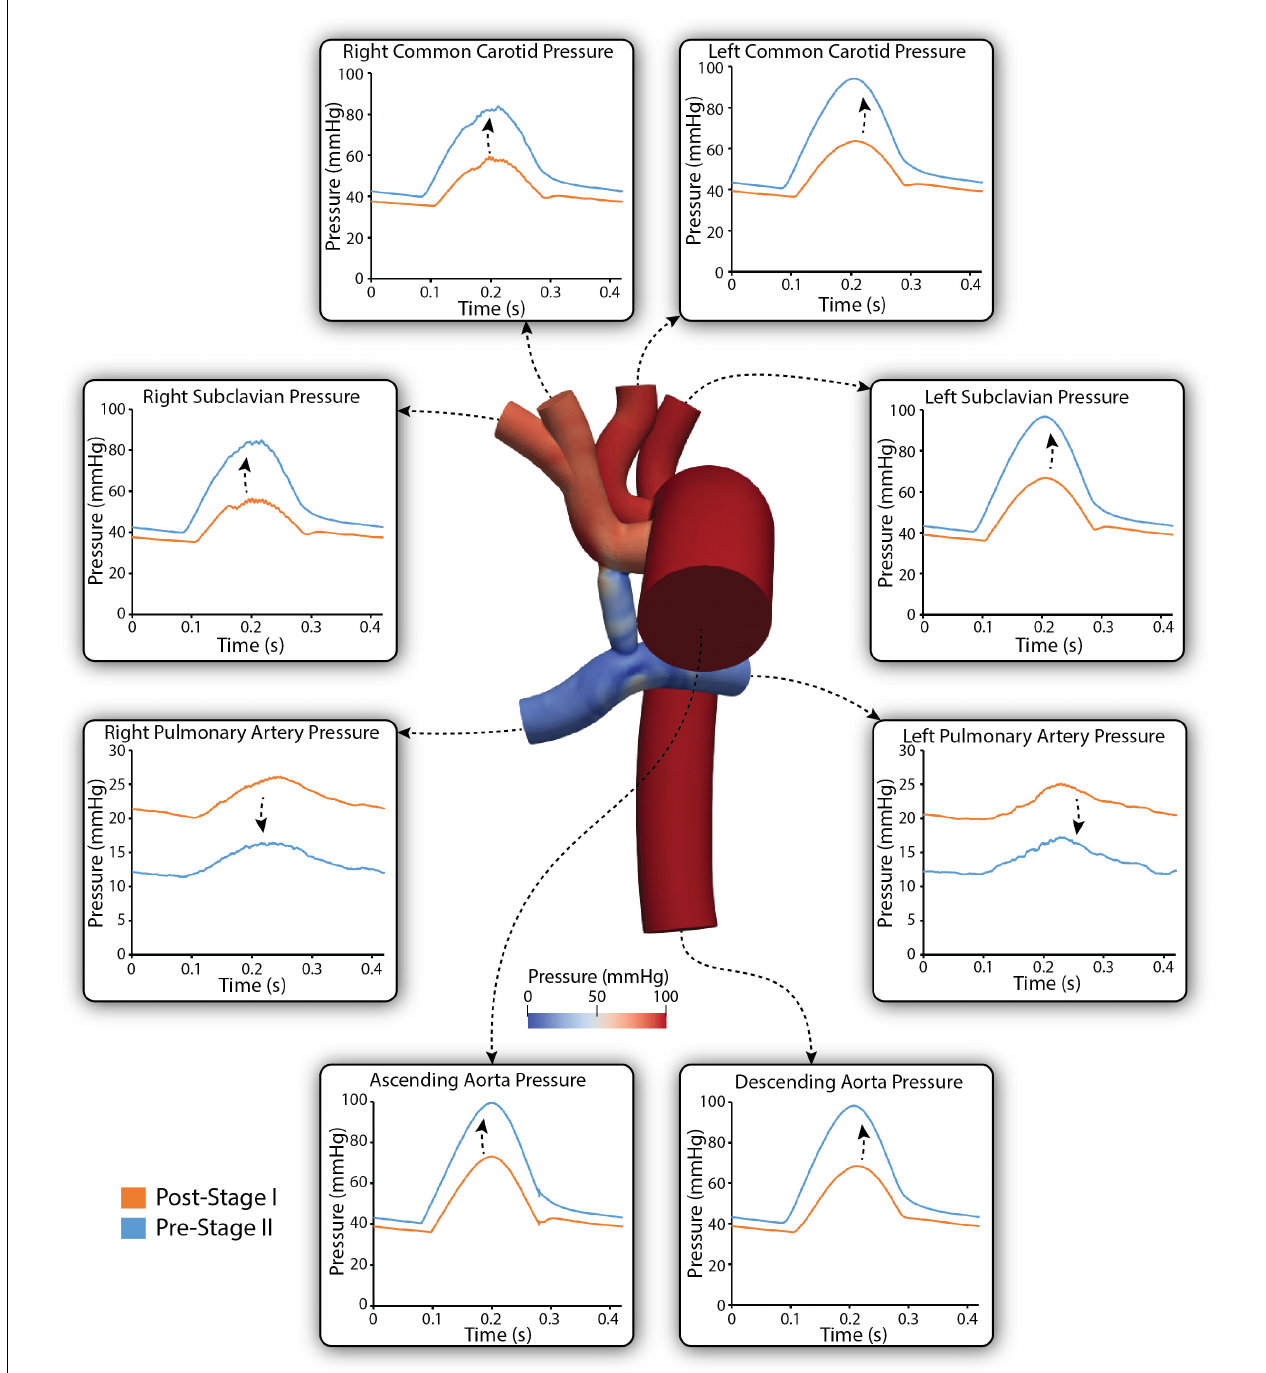
FIGURE 7 | Simulated pulsatile pressures at all boundaries of the 3D domain for both post-S1 (orange) and pre-S2 (blue) models. Arrows indicate whether pressure increased or decreased from post-S1 to pre-S2. Note that two different y -axis scales have been used: one for the LPA and RPA, and a second for the remainder of the outlets. A pressure coloring on the surface of the pre-S2 model is shown during peak-systole ( t = 0.21 s).